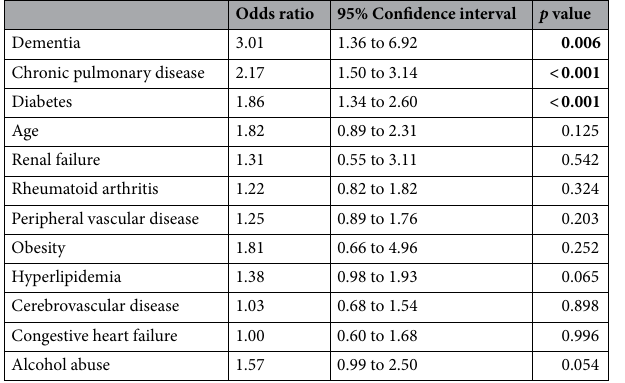
Table 2. Results of multiple logistic regression analysis. Bold values indicate statistically significant findings. *Chi-square test or Fisher’s exact test. Significance at p < 0.05.